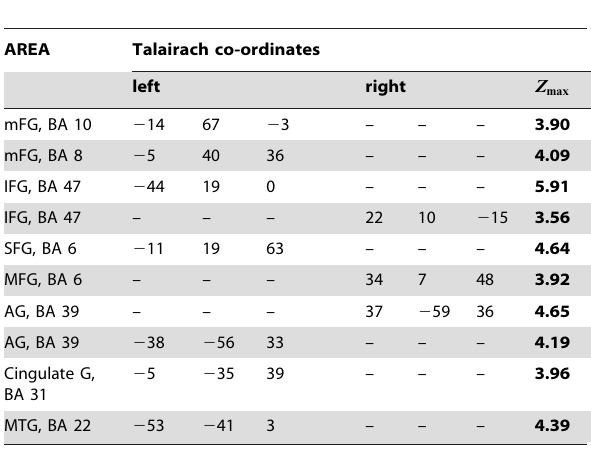
Table 2. Flat incorrect vs. Flat